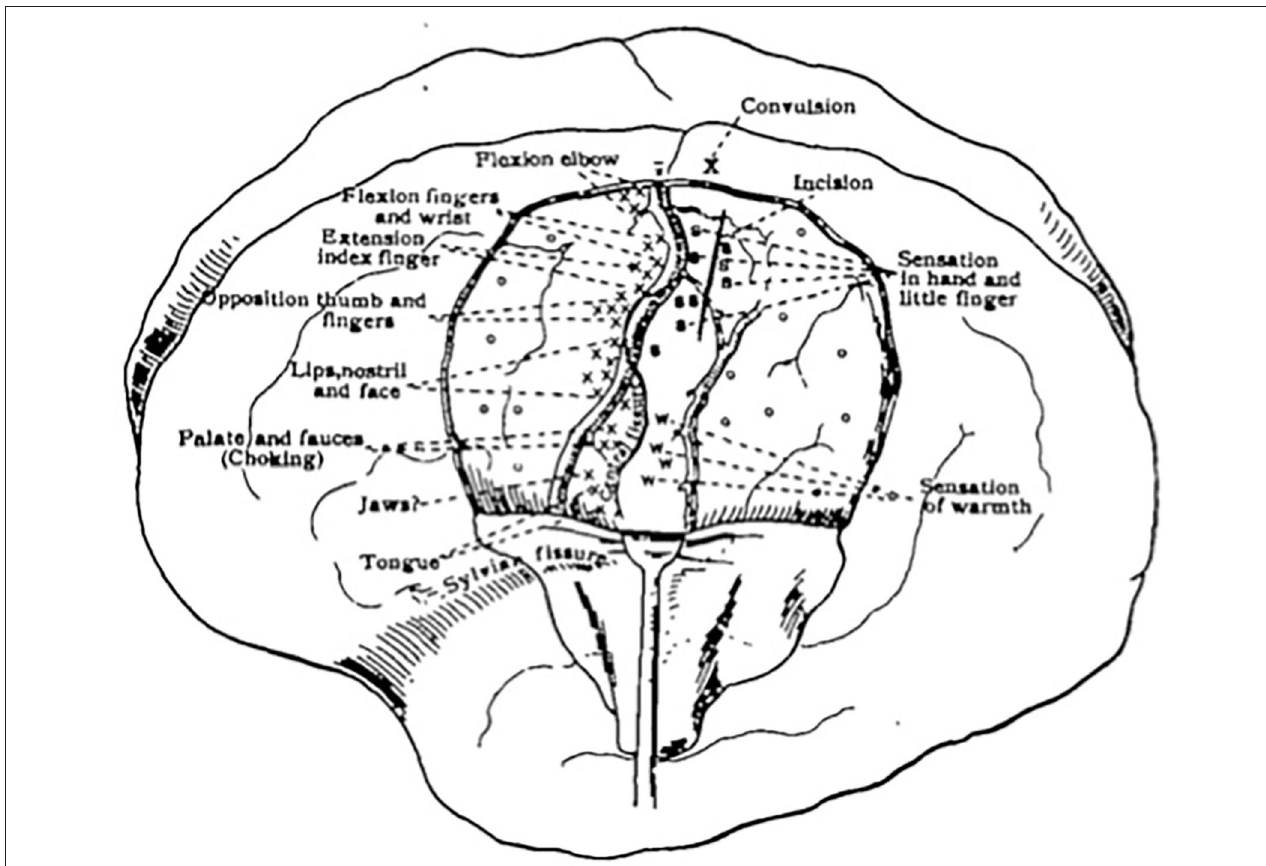
FIGURE 1 | First sketch mapping motor and sensory responses during an awake craniotomy. Reprinted from Cushing H., A note upon the faradic stimulation of the postcentral gyrus in conscious patients, Brain, 1909;32(1):44–53 by permission of Oxford University Press.